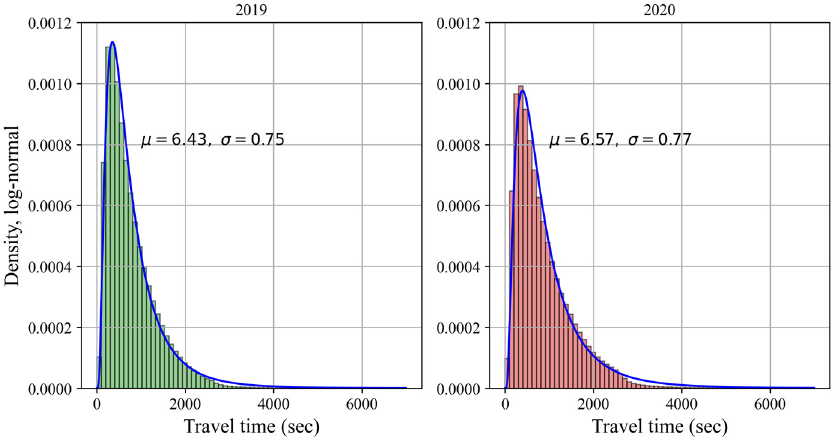
Figure 3. Probability density functions for travel time before and during